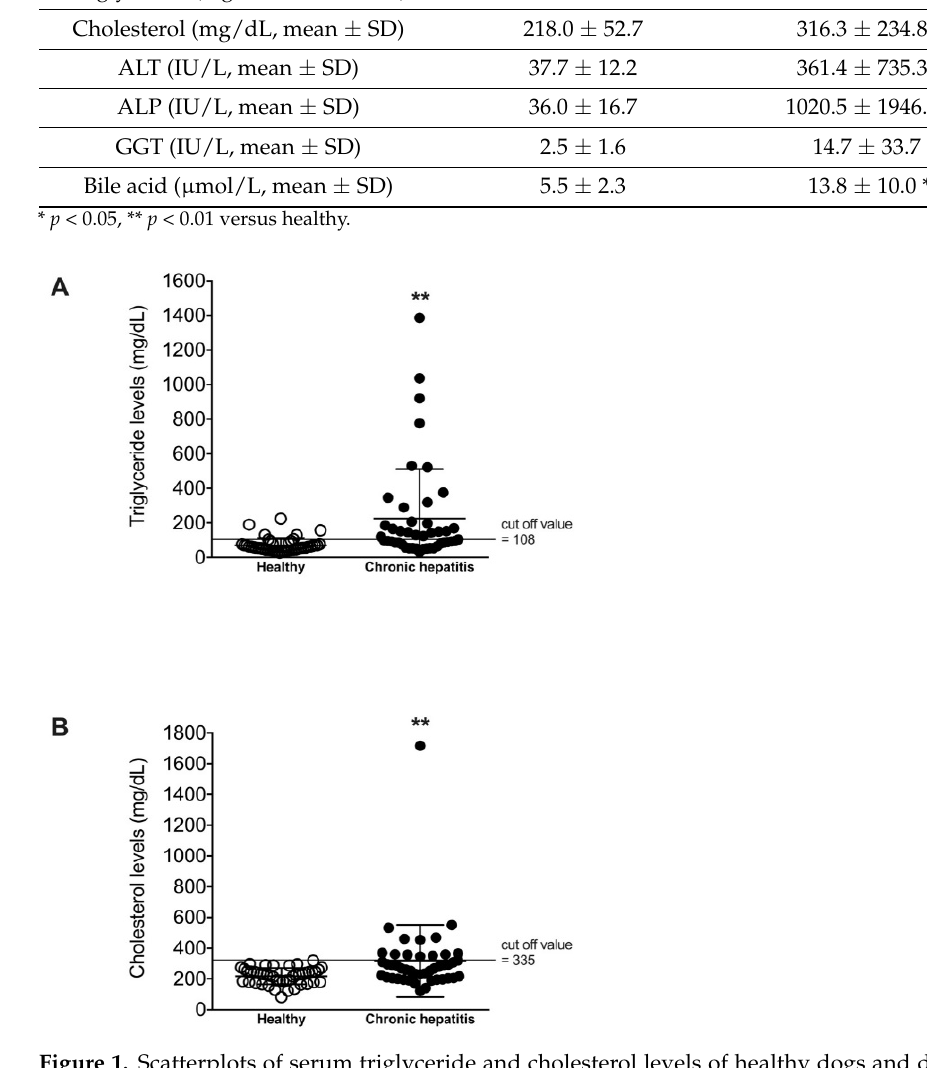
Table 2. Hyperlipidemia, as determined by the elevation of lipids (triglyceride > 108 mg/dL or cho- lesterol > 335 mg/dL), in healthy dogs and dogs with chronic hepatitis.